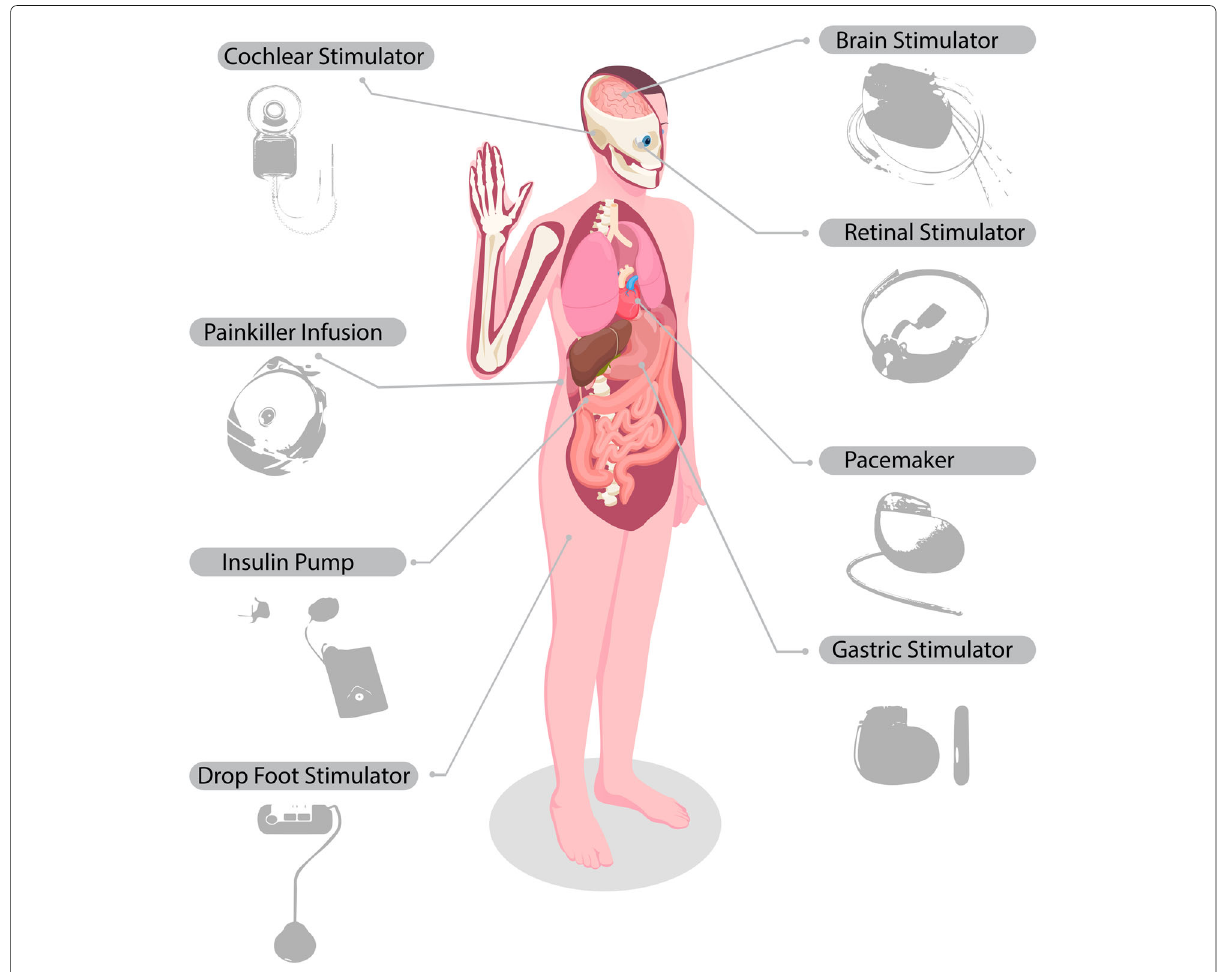
Fig. 3 Some of implantable devices